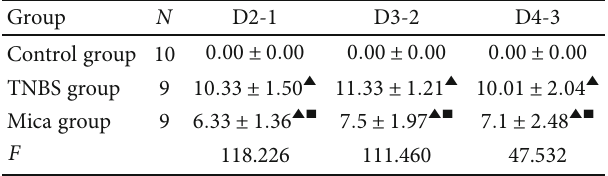
Table 5: Disease activity index ð (cid:1) x ± s Þ